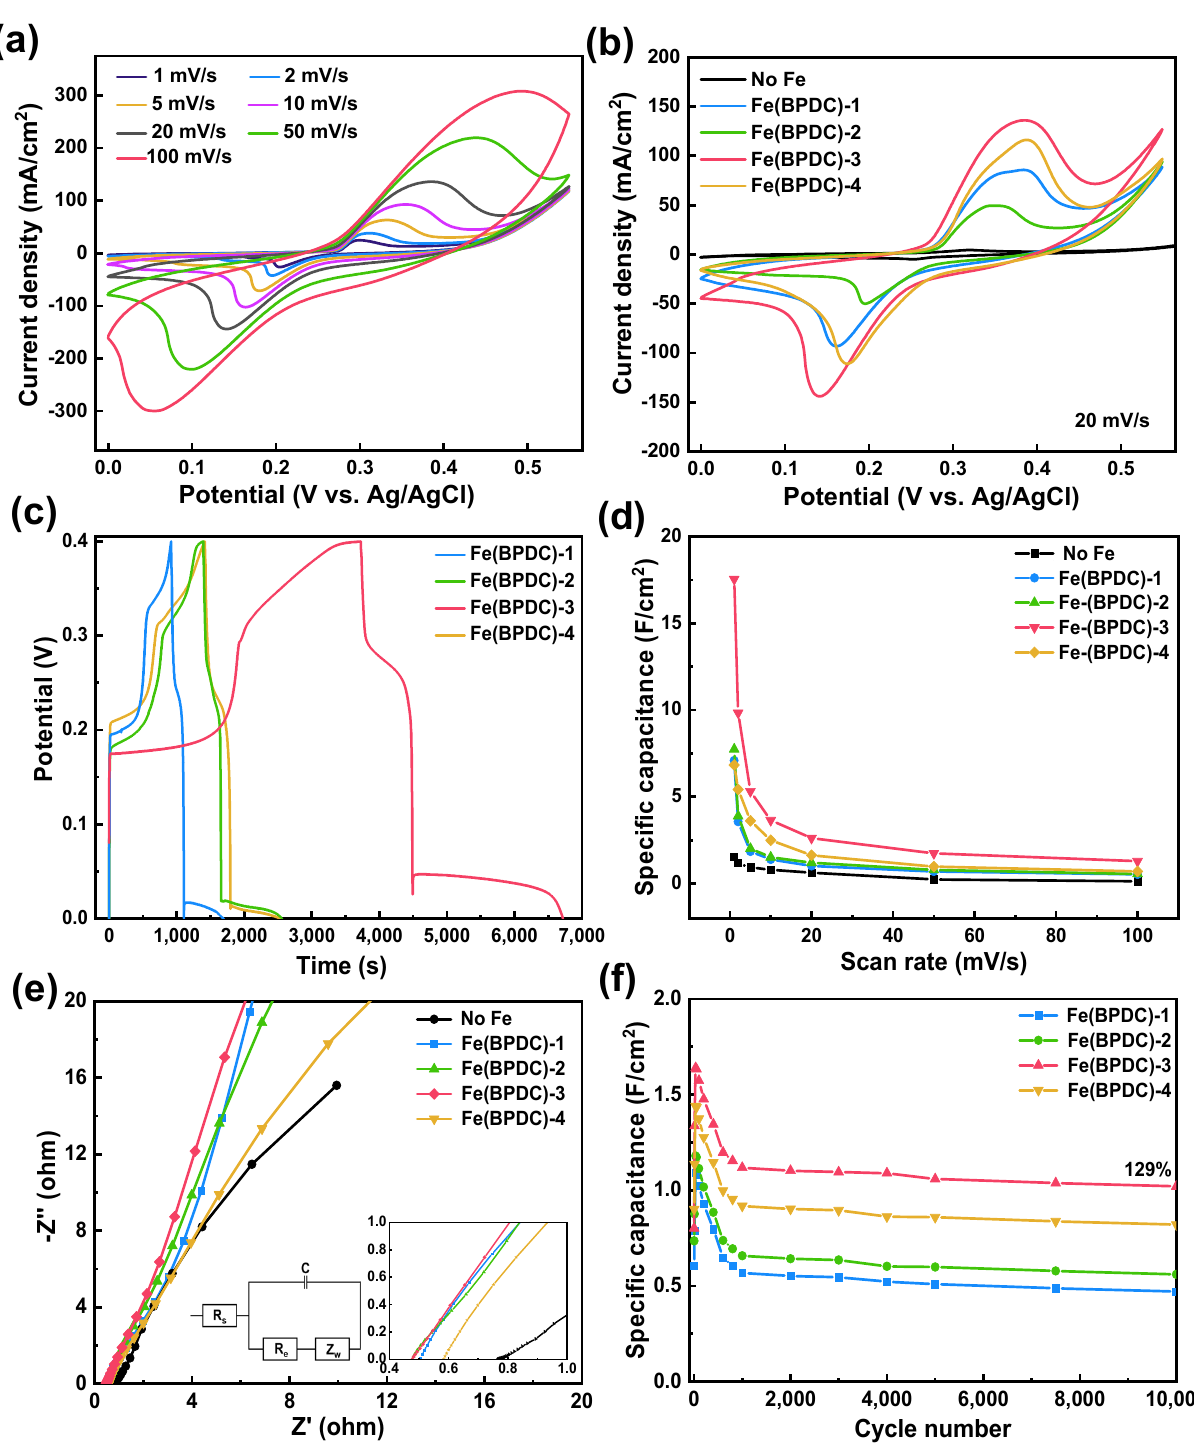
Figure 4. ( a ) CV curves of Fe(BPDC)–3 at a scan rate of 1 mV/s to 100 mV/s. ( b ) CV curves at a scan rate of 20 mV/s ( c ) GCD curves at the current density of 2 mA/cm 2 . ( d ) The specific capacitance of Fe(BPDC)–X at different current densities. ( e ) EIS curves of Fe(BPDC)–X. ( f ) Cycling stability of the Fe(BPDC)–X electrode.